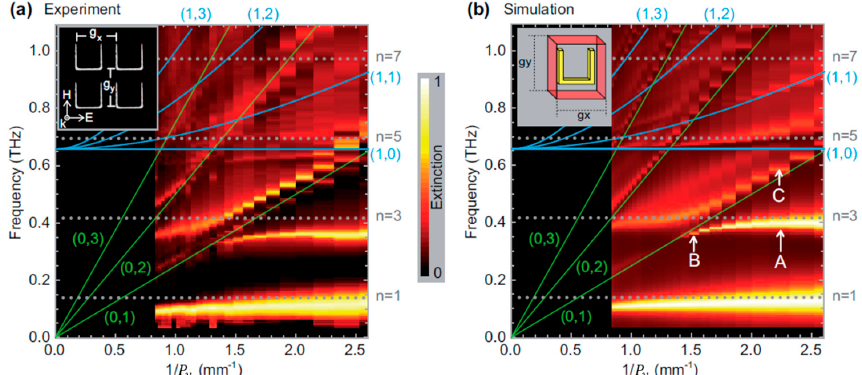
Figure 6. Strong coupling between a single resonance and a lattice mode. Dispersion diagrams obtained from ( a ) measured and ( b ) simulated transmission spectra. The lattice constant, P y varies from 380 to 1200 µ m while P x is kept constant at 380 µ m. Plasmonic structural resonances are indicated by the gray dotted lines and the lattice modes by green and blue solid lines. A and B mark weak and strong radiative coupling for the n = 3 structural mode and a pure lattice mode is marked by C. Adapted with permission from ref [38], The Optical Society.